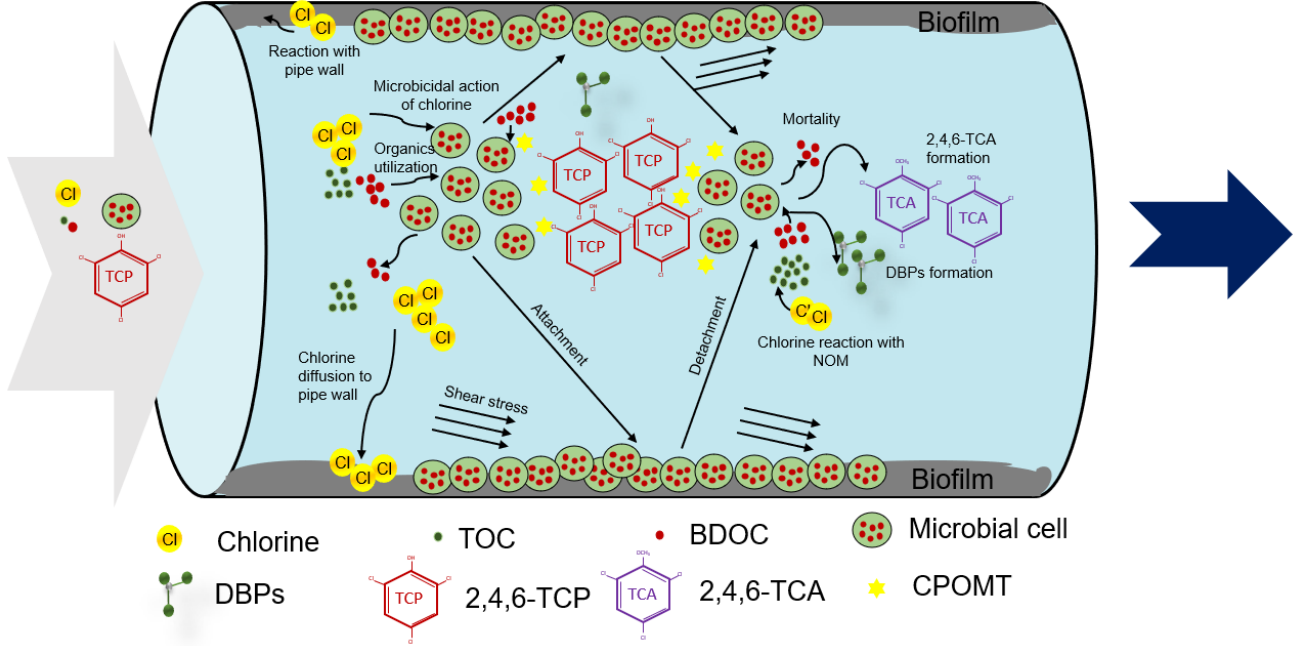
Figure 2. Schematic representation of multi-species reactive-transport (MSRT) model domain.